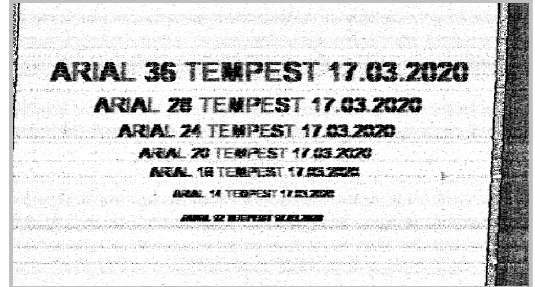
Figure 12. Image recovered when Arial font with upper case letters was displayed.